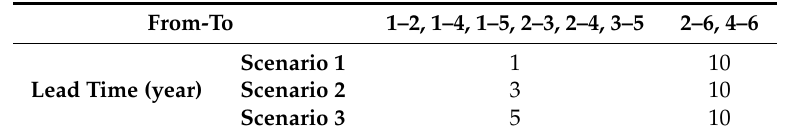
Table 5. Different lead times of investment candidates.